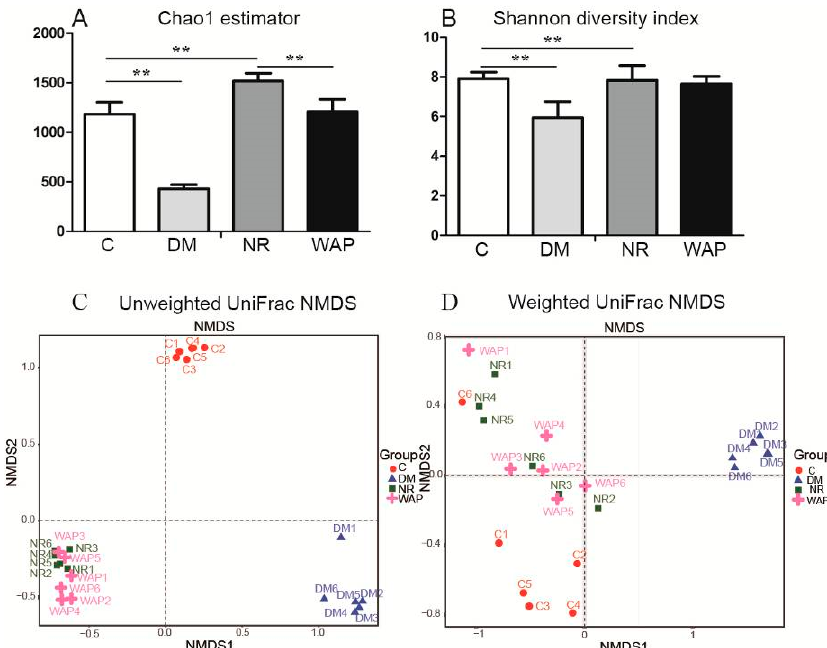
Figure 4. α and β diversity analysis of the gut microbiota. ( A ) Chao1 estimator; ( B ) Shannon diversity index; ( C ) unweighted UniFrac NMDS; ( D ) weighted UniFrac NMDS. C, control group; DM, antibiotic-associated diarrhea group; NR, natural recovery group; and WAP, Astragalus polysaccharide group. Data are expressed as means ± S.D. ( n = 6). ** p < 0.01.